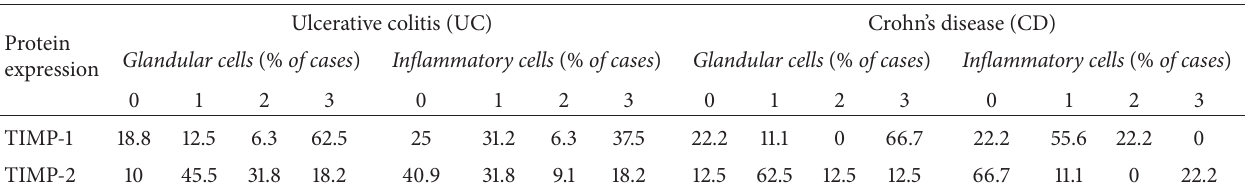
Table 3: Immunohistochemical expression of TIMP-1 and TIMP-2 in glandular tubes and inflammatory cells in tissues of ulcerative colitis and Crohn’s